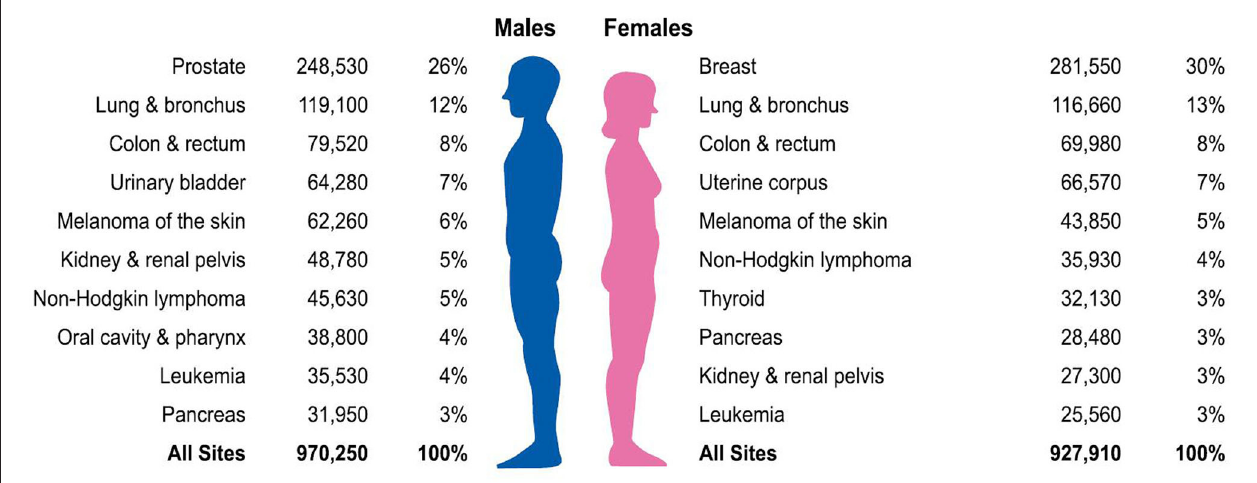
FIGURE 1 | Ten leading cancer types for the estimated new cancer cases by sex, United States, 2021.